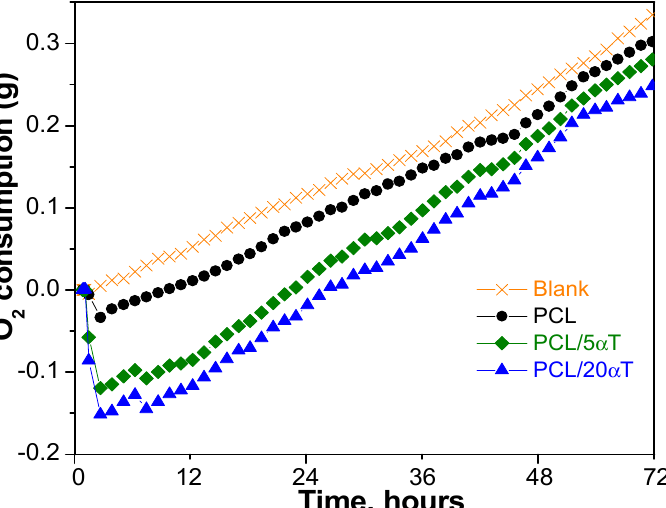
Figure 11. Oxygen consumption during curd cheese storage in presence of electrospun fibers from